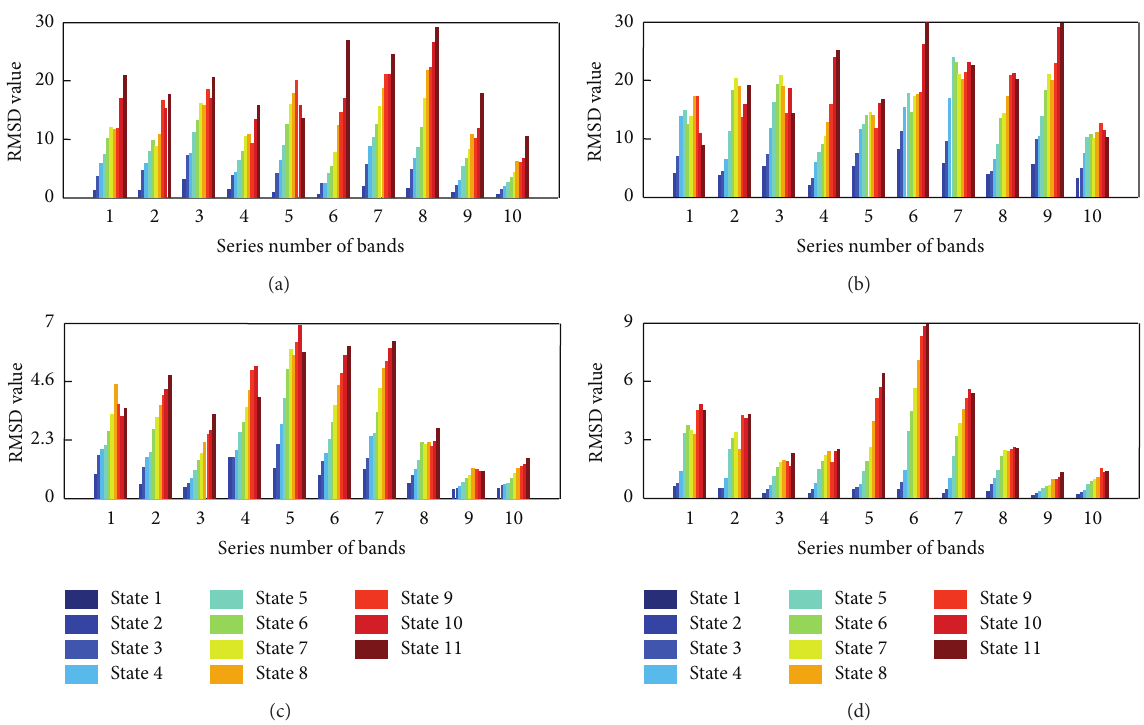
Figure 8: RMSD values of different subfrequency ranges for the structure under different health states and the mapping between different health states and the color of histograms: (a) the variation of rod 1; (b) the variation of rod 2; (c) the variation of rod 3; (d) the variation of rod